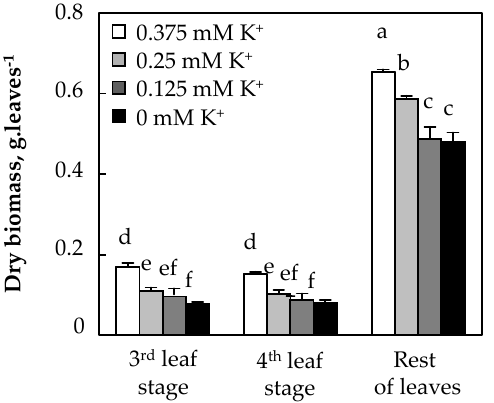
Figure 3. Dry weight of the third and fourth leaves and remaining leaves of O. basilicum plants. Cf. leg. Figure 2.